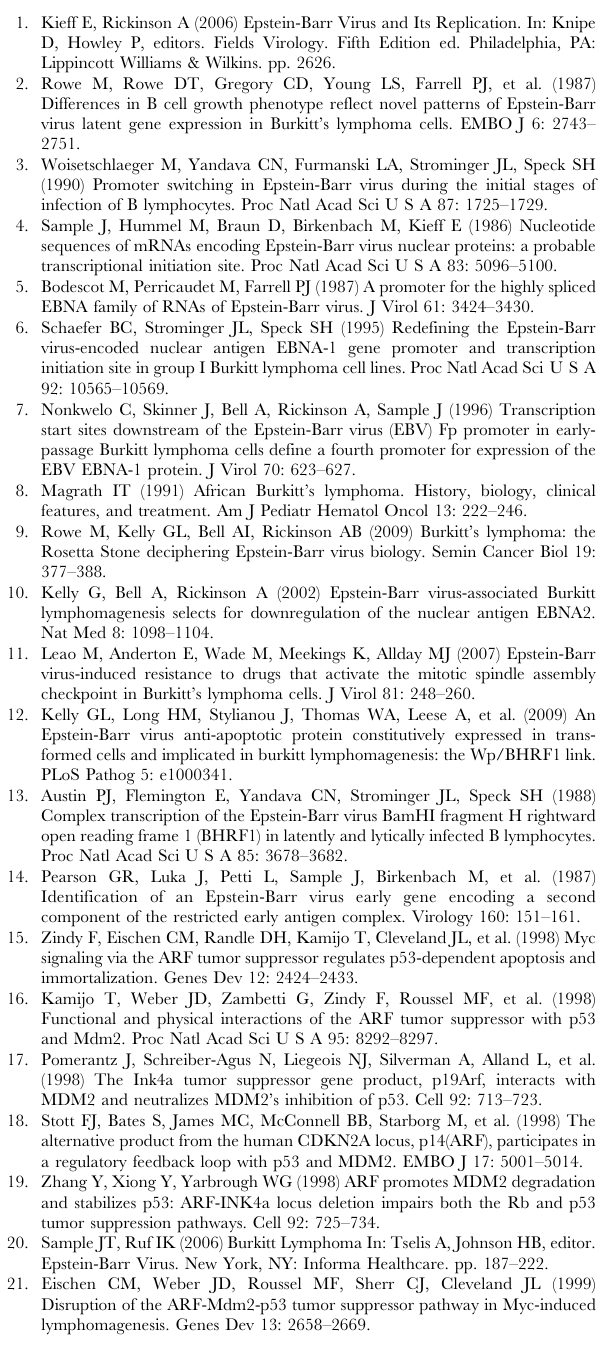
Table S1 Knockdown of EBNA-3A with either shRNA results in G0/G1 cell cycle arrest while control shRNAs have no effect. Sal cells were transfected as described previously and cell cycle analysis was performed as described for Figure